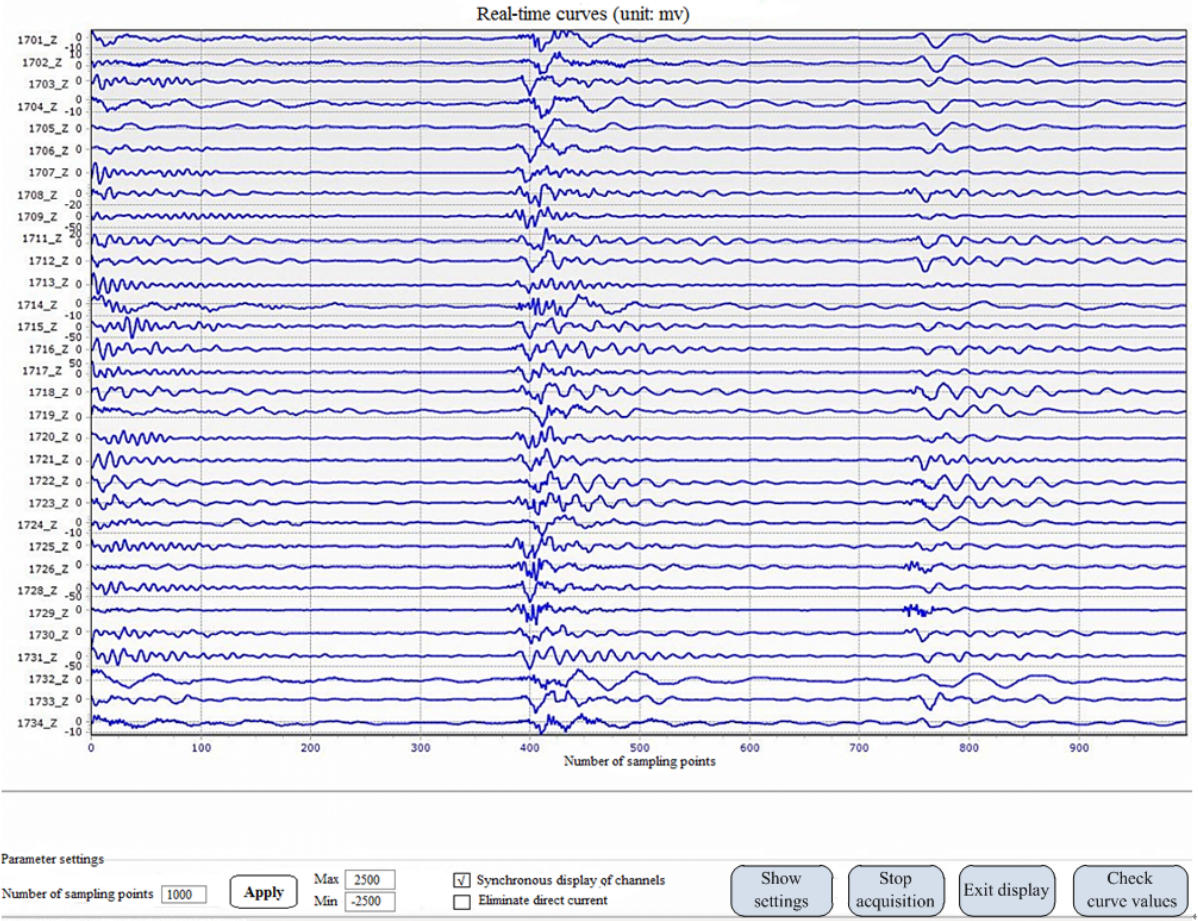
Figure 10. Test chart of the acquisition station